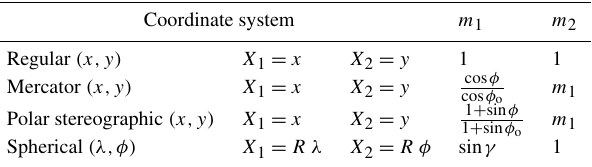
Table 8. Horizontal mapping factors (x,y) ← (X 1 ,X 2 ) for differ- ent coordinate systems where λ is longitude, φ latitude, R the ra- dius of the Earth, γ the colatitude, and φ o the latitude at which the projection is true. Mercator and polar stereographic projections use Cartesian coordinates projected into the Earth’s surface, i.e. account for curvature. Regular Cartesian coordinates should be used only for local domains, where the Earth’s curvature can be neglected.